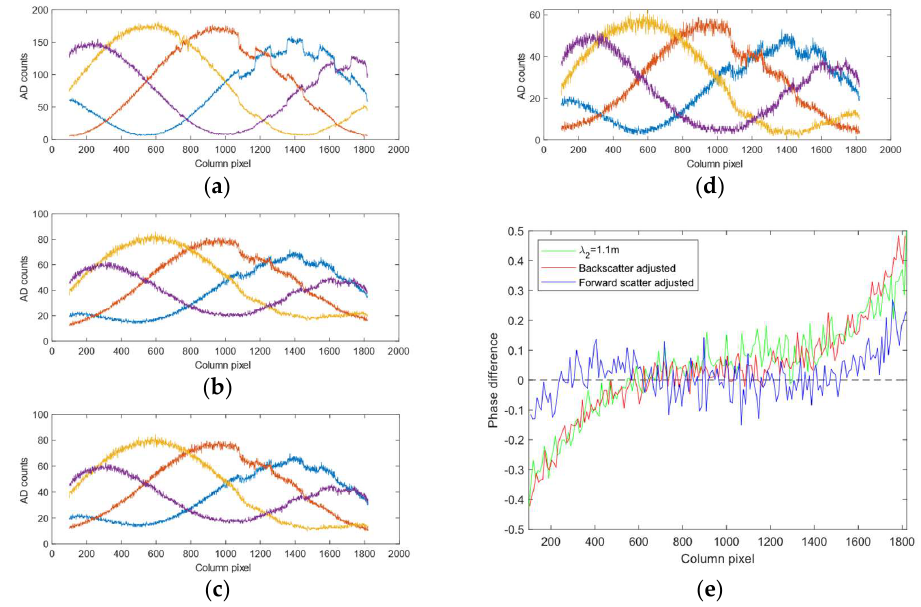
Figure 10. Scatter compensation at turbidity level λ 2 = 1.1 m. The intensity and phase profiles are